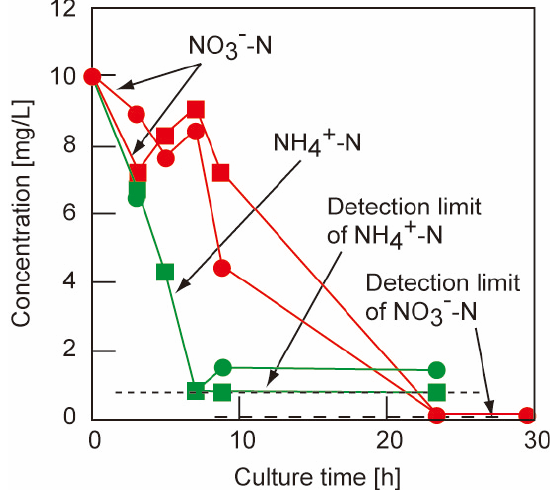
Figure 4. Simultaneous nitrogen removal of nitrate nitrogen and ammonia nitrogen by alginate beads: red symbols, nitrate-nitrogen concentration, green symbols, ammonia-nitrogen concentration, Circle and square symbols indicate first run and second run, respectively. The detection limit of nitrate nitrogen by the ion chromatography method is 0.2 mg/L, and that of ammonia nitrogen by the indophenol blue method is 0.8 mg/L.